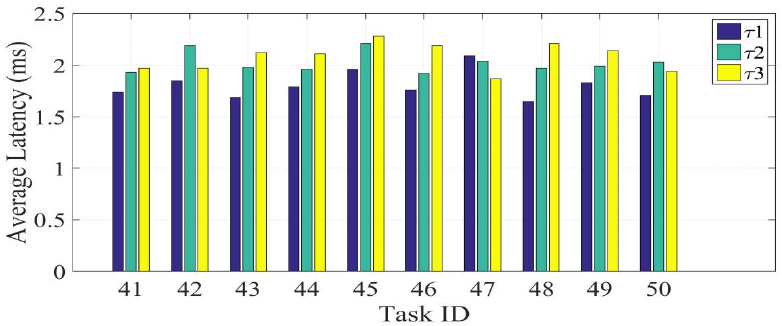
Figure 14. The average latency of handling the fifth group of tasks.